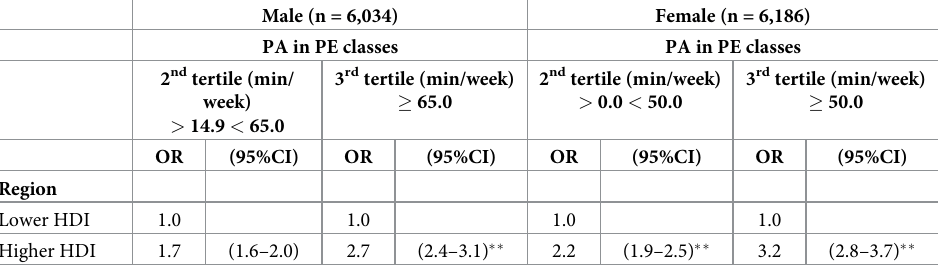
Table 3. Association between physical activity time during physical education classes and geographic region of residence according to sex (n =